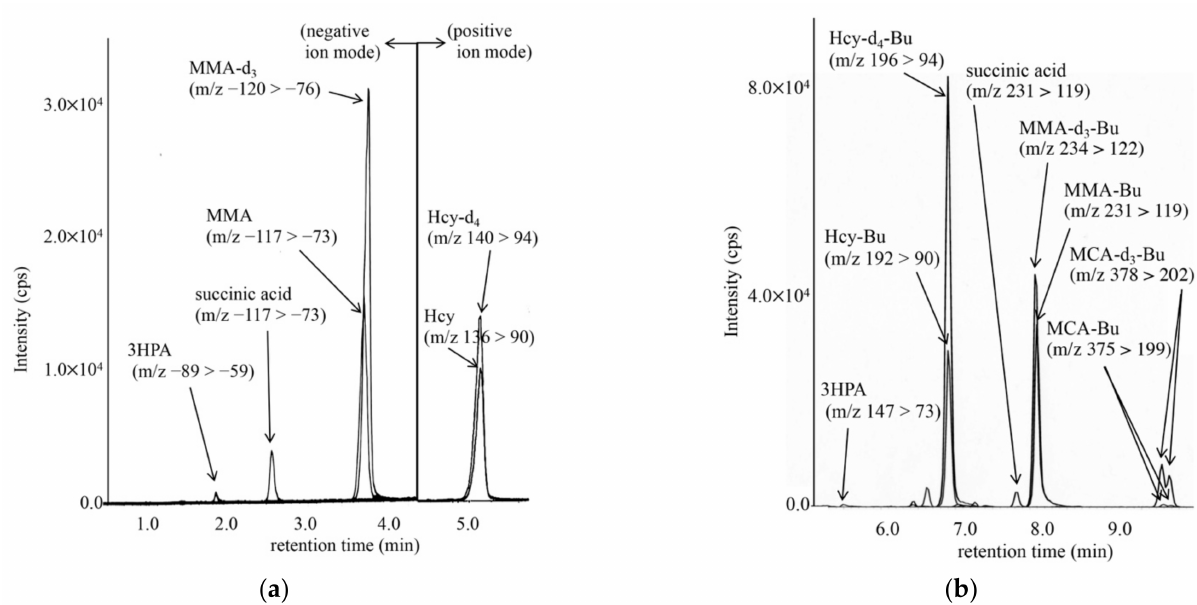
Figure 2. LC-MS/MS analysis of underivatized organic acids, including methylmalonic acid (MMA) using negative ion mode and homocysteine (Hcy) by positive ion mode ( a ), and that for derivatized organic acids, including methylcitric acid butyl-ester (MCA-Bu) and Hcy butyl-ester (Hcy-Bu) by positive ion mode ( b ). The gradient elution program in ( a ) was as follows: 13% B (0.5 min), 13% to 30% B (6 min), 30% to 100% B (0.1 min), 100% B (7.9 min), 100% to 10% B (0.1 min), and 13% B (5 min); that in ( b ) was as follows: 0% B (0.2 min), 0% to 80% B (1 min), 80% to 100% B (9 min), 100% B (3 min), 100% to 0% B (0.1 min), and 0% B (3 min).